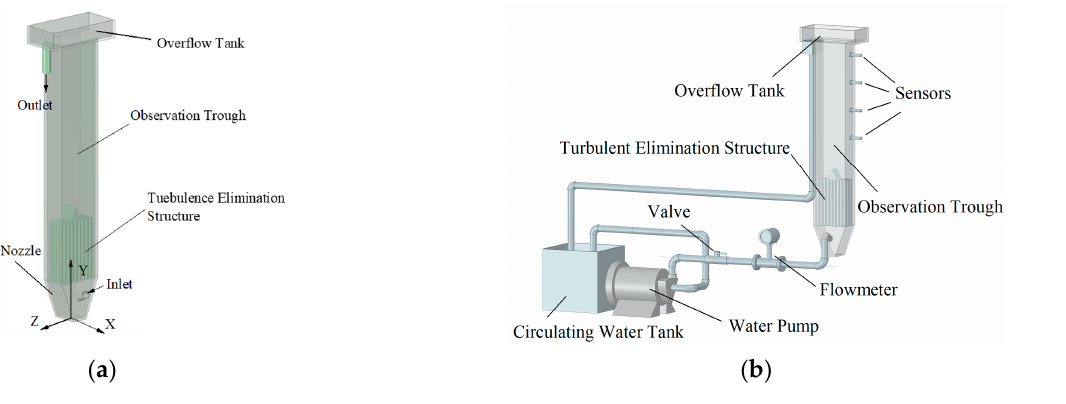
Figure 3. Grids of different structures. ( a ) Grids corresponding to different lengths of the TES. ( b ) Grids corresponding to different inlet angles.